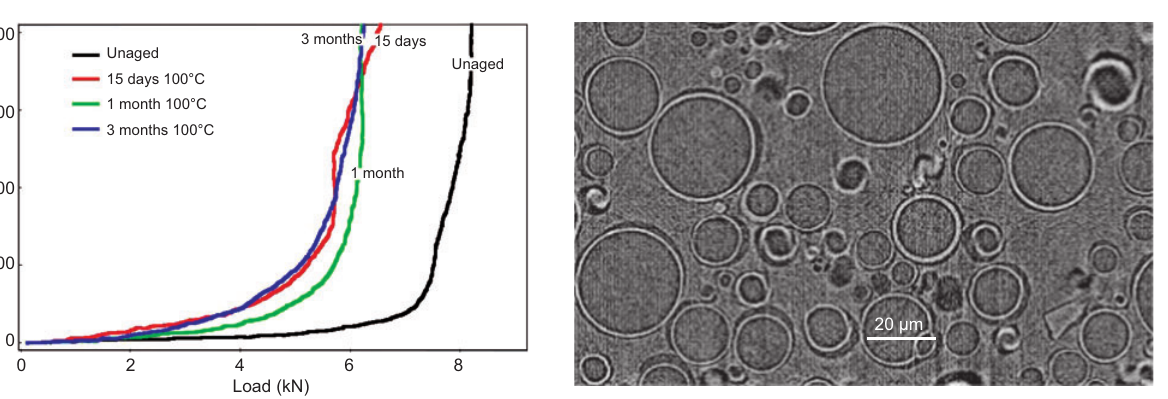
Figure 9 Acoustic emission activity of MS3 aged at 60 ° C [number of hits vs. load (kN/10)].